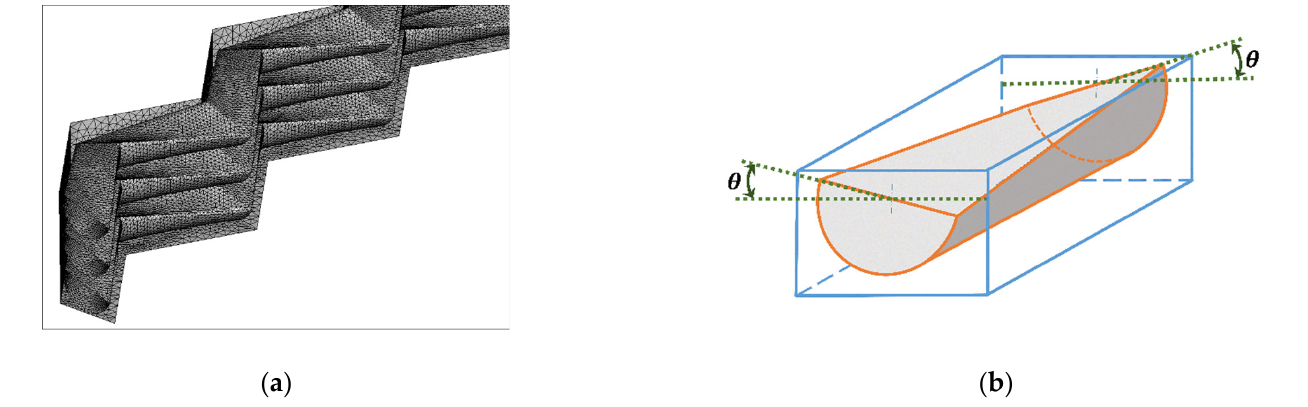
Figure 9. Improved spiral Z-type structure diagram: ( a ) The mesh of S-ZPCHE; ( b ) The spiral angle θ of S-ZPCHE.